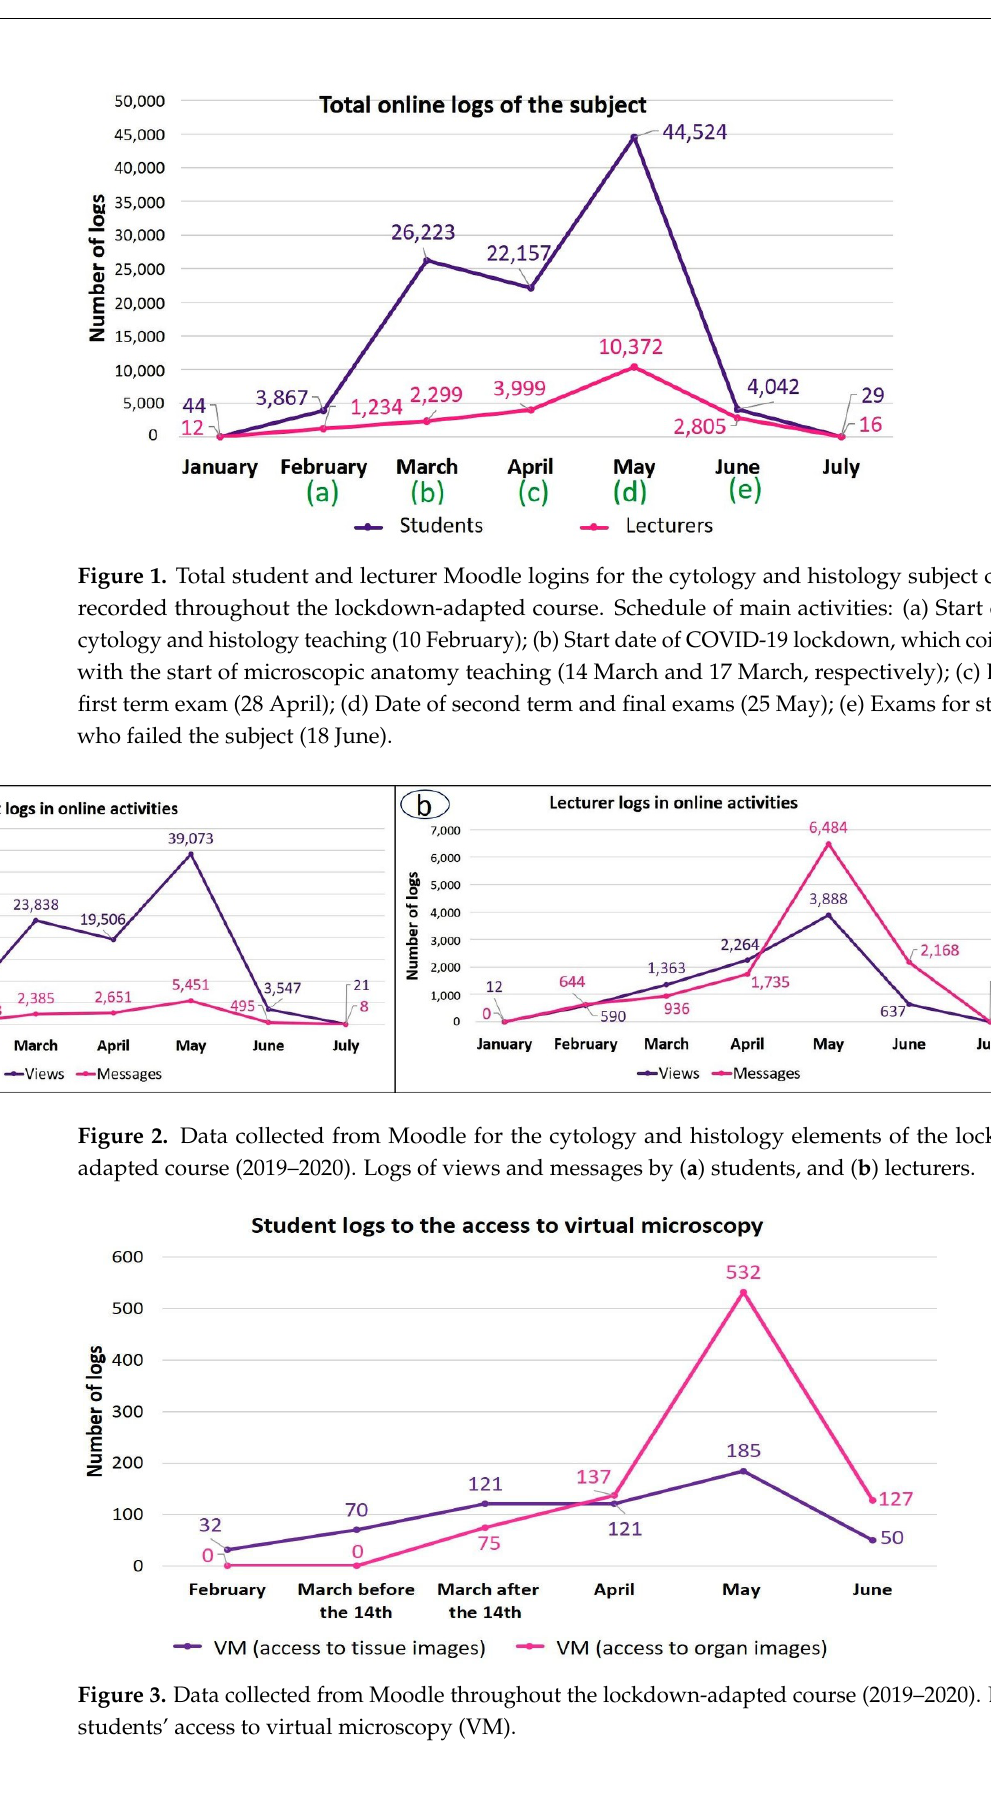
Figure 3. Data collected from Moodle throughout the lockdown-adapted course (2019–2020). Logs of students’ access to virtual microscopy (VM). 3.2. Student Outcomes: Comparing Face-to-Face and Lockdown-Adapted Evaluation Procedures Looking first at performance in the theory exams, both student cohorts (2018–2019 and 2019–2020) received traditional, face-to-face teaching for the cytology and histology course component and statistical analysis revealed that the percentage of students who passed exam 1 (cells and tissues) was similar when they were examined in-person and online (exams 1a and 1b, respectively). In contrast, the pass rate for exam 2 (on organs) was significantly higher for students in the lockdown cohort, who had access to online resources during the teaching phase and were also examined online: the pass rates for exams 2a (face-to-face) and 2b (online) were, respectively, 69.8% and 89%) ( p = 0.001) (Figure 4a).